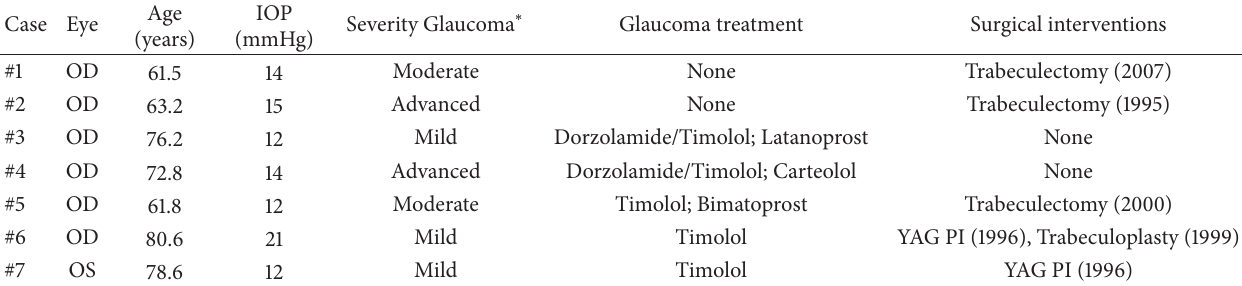
Table 1: Subject characteristics.